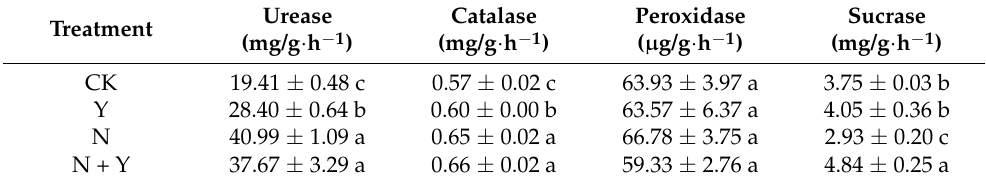
Table 4. Effects of cucumber rhizospheric growth media enzyme activities in different treatments.